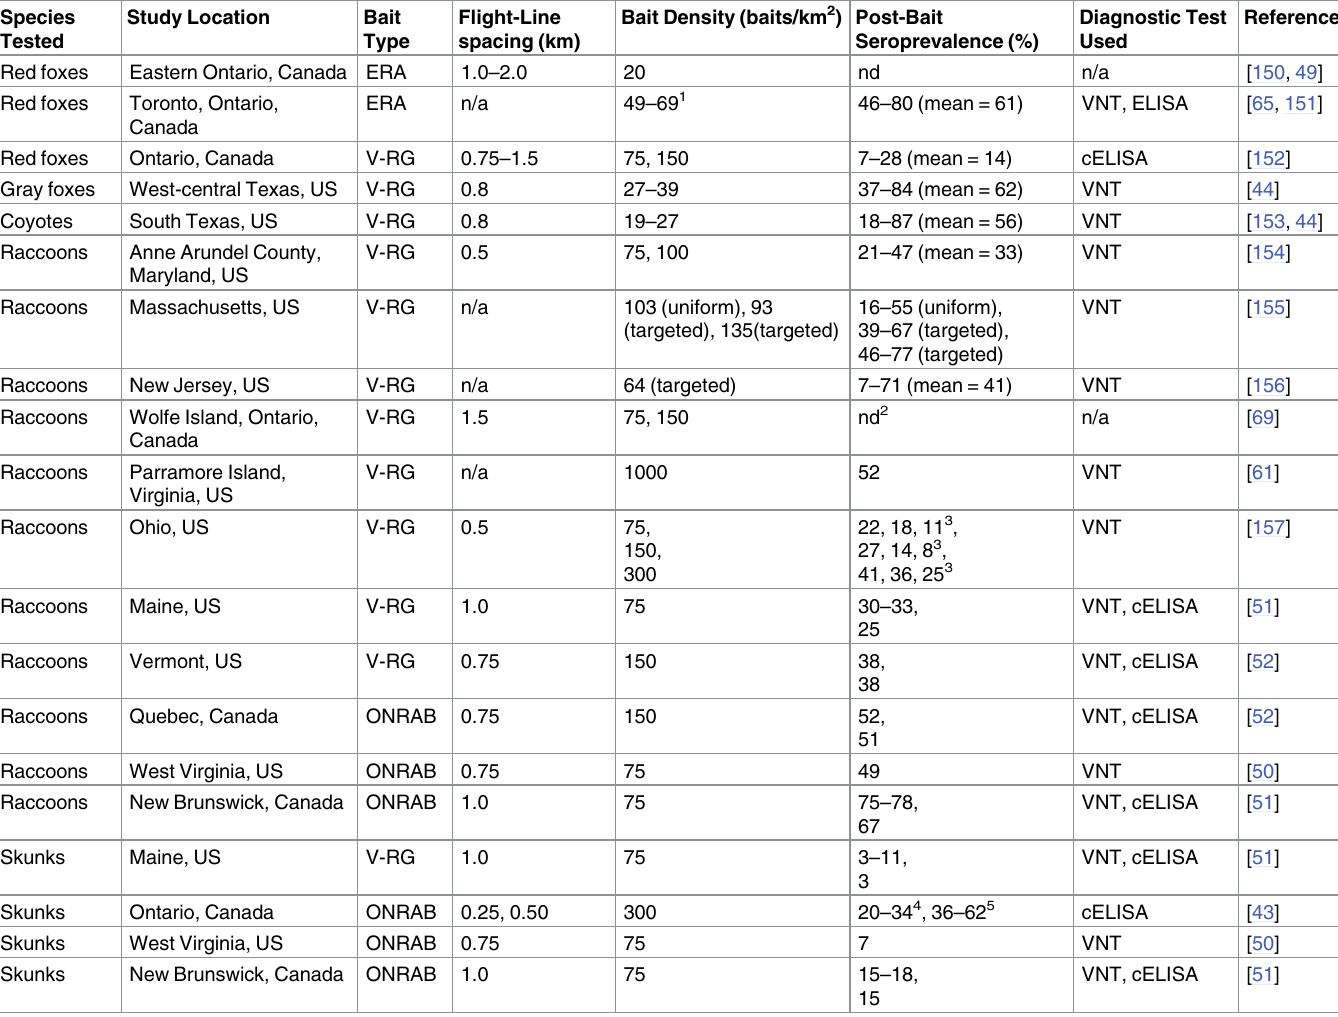
Table 1. Previously published ORV campaigns in North America and the estimated population seroprevalence in response to vaccination. Species